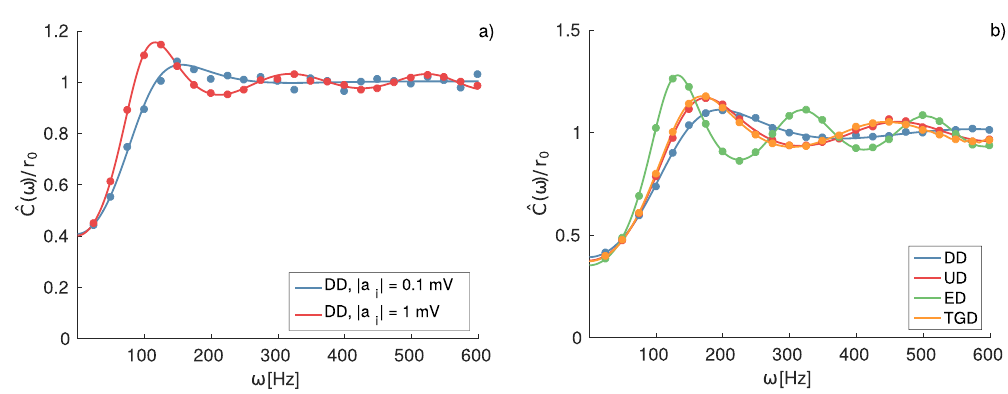
Figure 3. Spike Train Spectra. ( a ) Normalized spike train spectra ω ˆ C r ( )/ for the same cases shown in 0 Fig. 1(a,b) for an effective input μ T = 9 mV and noise intensity σ 2 = 2 mV 2 ; ( b ) Normalized spike train spectra for the distributions considered in Fig. 2(a,b) for 〈 | a i | 〉 = 1, μ T = 9 mV and σ 2 = 4 mV 2 . In both panels, the symbols correspond to the simulation results, while the continuous line to the theoretical estimations using Eq. (22). Simulated spectra were obtained by calculating the squared modulus of the Fourier transform of the spike train using a time trace of 64 s with 1 ms binning, and averaging over 10,000